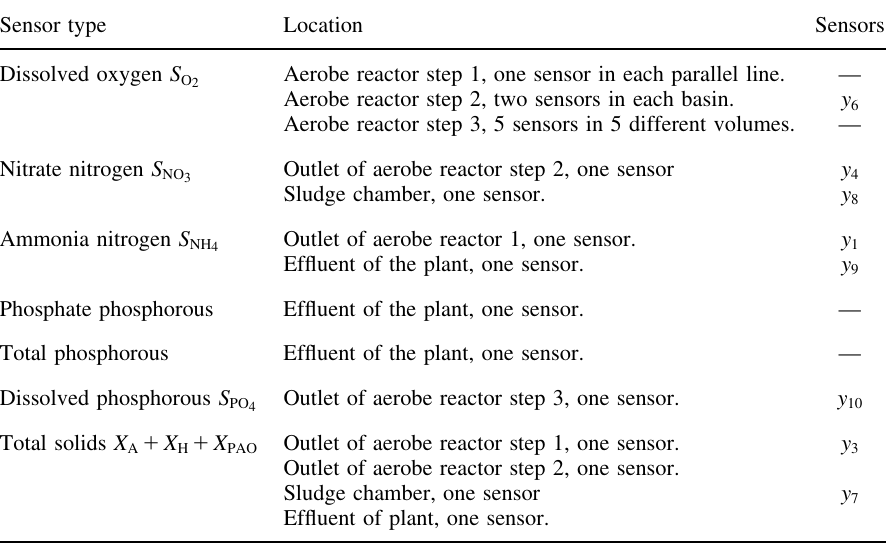
Table 3. On-line sensors at the Duvbacken Waste Water Treatment